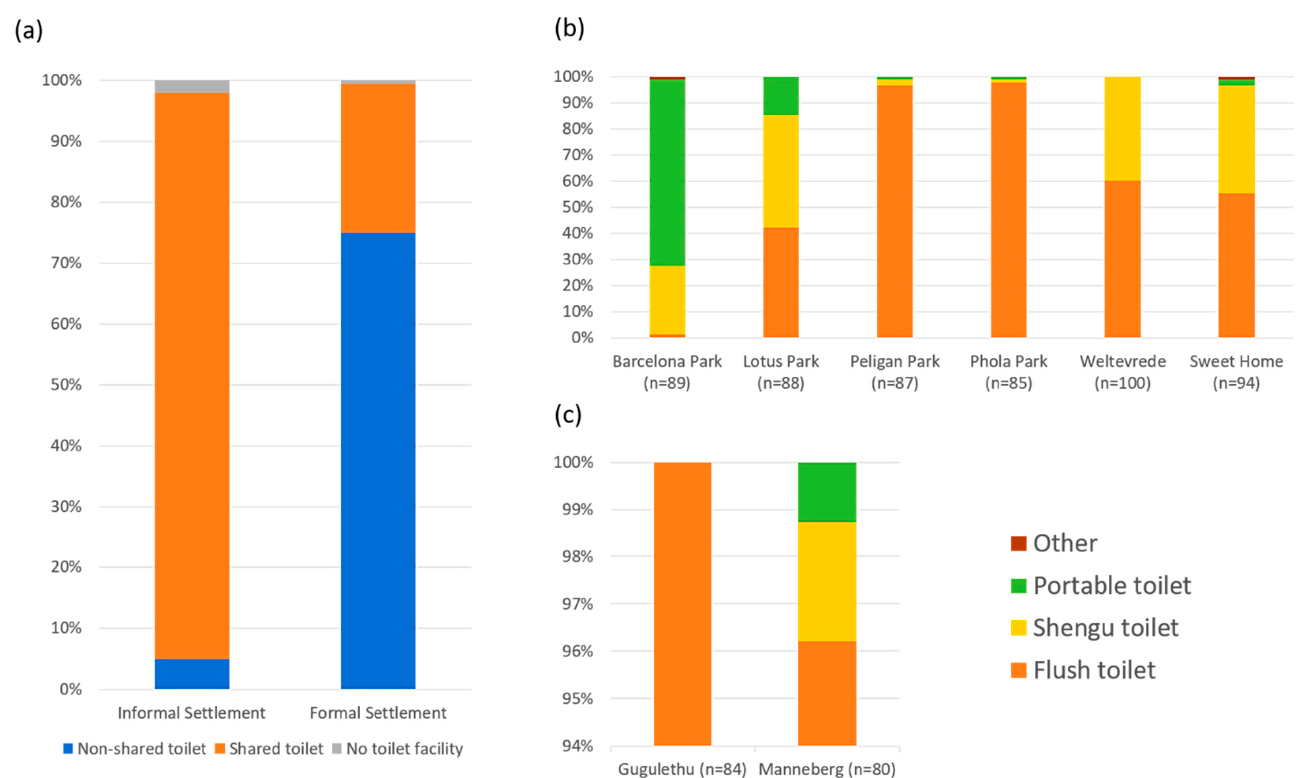
Figure 3. Types of sanitation facilities available ( a ) in each settlement type; ( b ) in six informal settlements; and ( c ) in two formal settlements.